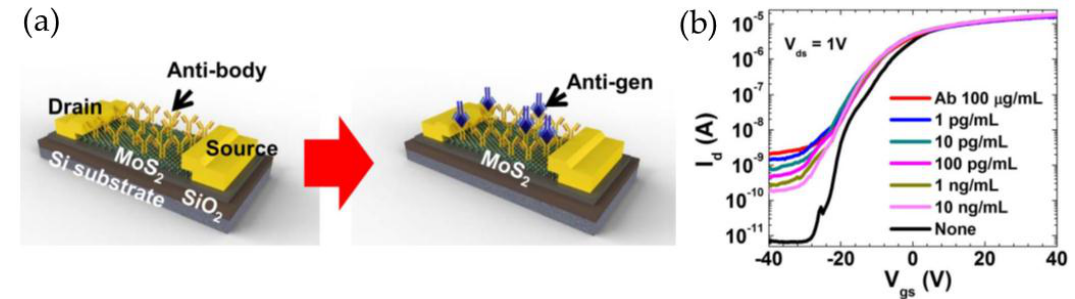
Figure 5. ( a ) Scheme showing the structure of the FET immunosensor based on MoS 2 nanosheets as sensing channel. PSA antibodies are physiosorbed onto MoS 2 and the antigen is selectively bound to the antibodies; ( b ) Transfer curves of the MoS 2 -FET immunosensor under different PSA concentrations. The analyte binding caused current increase. Lee et al. are fully acknowledged for the images [50].